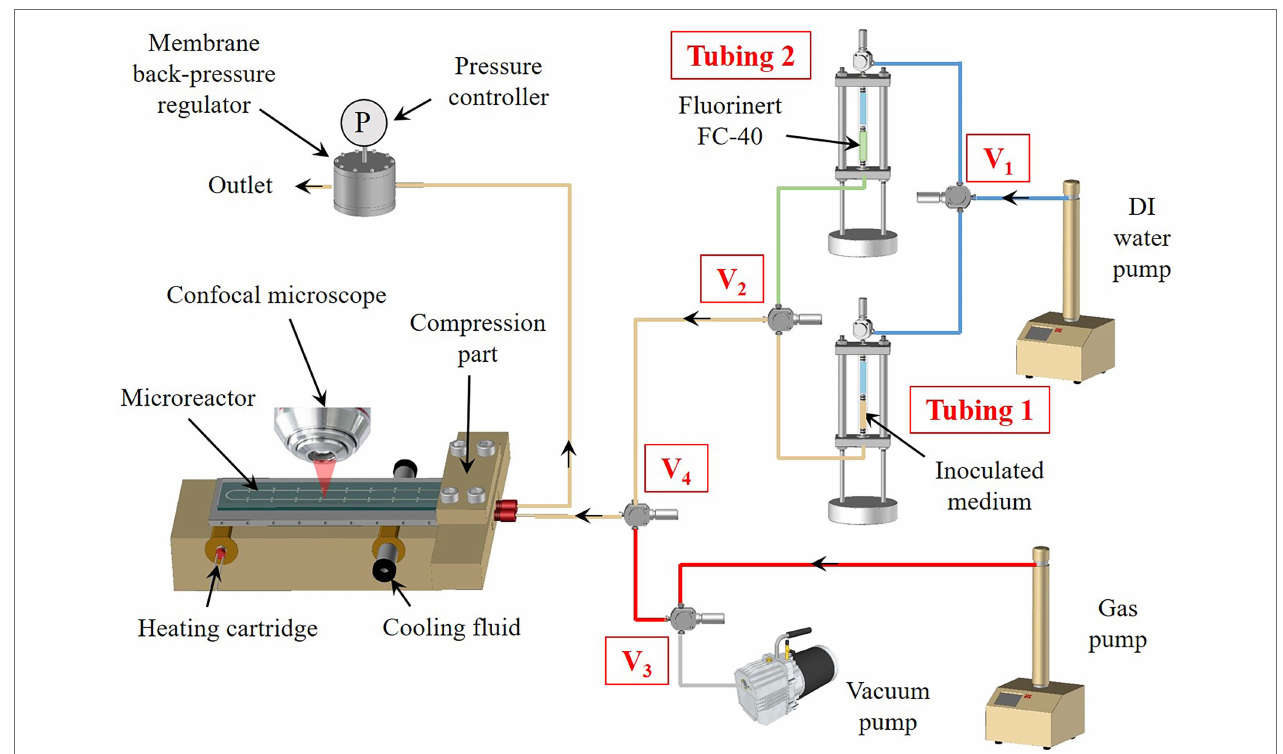
FIGURE 2 | Set-up of the high-pressure microfluidics platform for phenotyping microorganisms at temperature (see the description in the